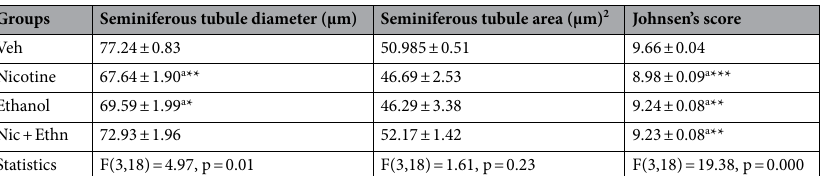
variable decreased significantly in the nicotine (p = 0.01) and ethanol (p = 0.05) groups in compared to that of the Veh group (Table 2). Seminiferous tubules area. The results of measuring seminiferous tubules area exhibited that developmental exposure to nicotine and ethanol, either alone or their combination did not change significantly (F 3,18 = 1.61, p = 0.23) this parameter in the testes of 90 day-old offspring when compared to that of the vehicle group (Table 2).